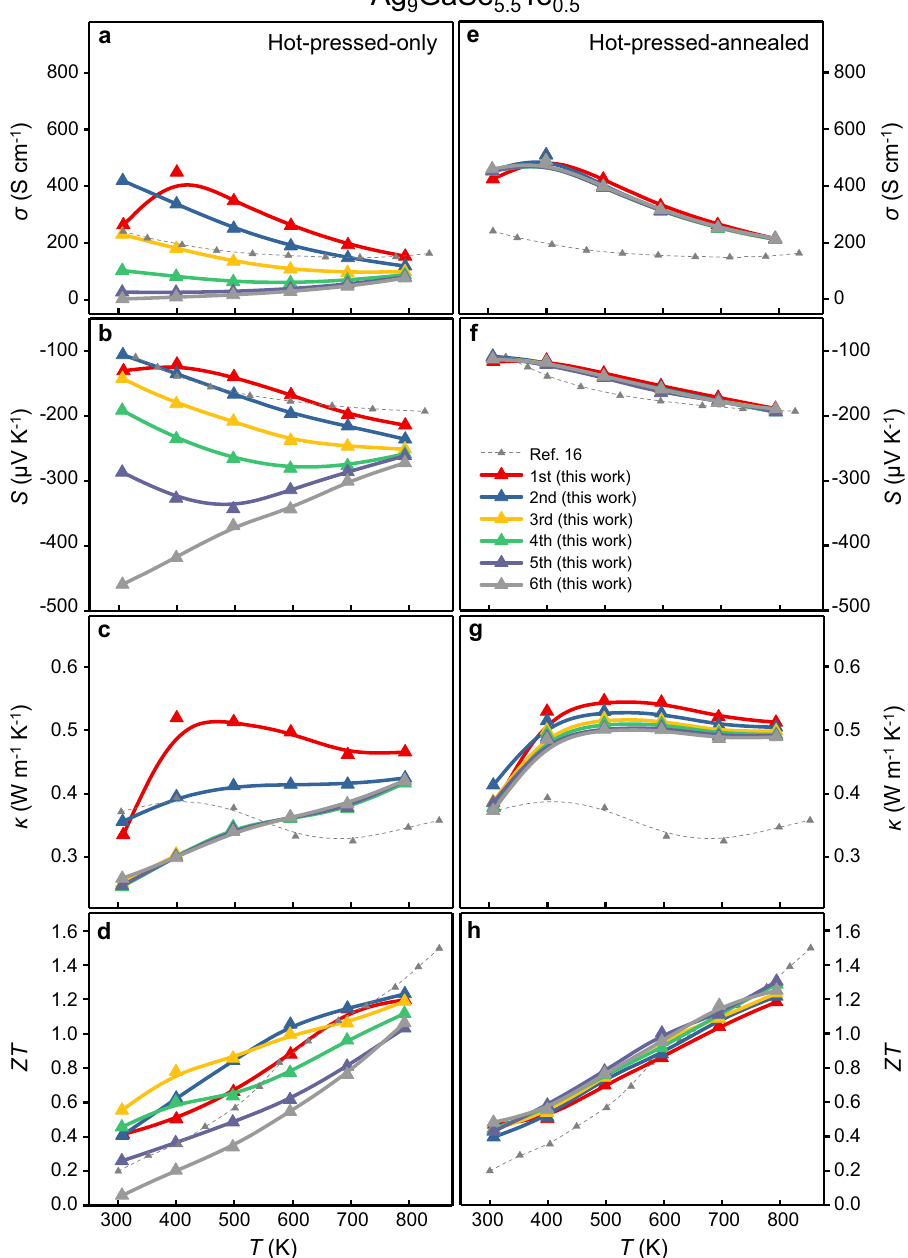
Fig. 3 Temperature-dependent thermoelectric properties of doped Ag 9 GaSe 5.5 Te 0.5 . a – d hot-pressed-only, and e – h hot-pressed-annealed samples. a , e Electrical conductivity σ . b , f Seebeck coef fi cient S . c , g Thermal conductivity κ . d , h Figure of merit ZT . The Dulong-Petit- C p was used. Those reported in ref. 16 that are calculated by the Dulong-Petit- C p are presented as references. The κ and ZT calculated by the measured- C p are provided in Supplementary Fig.